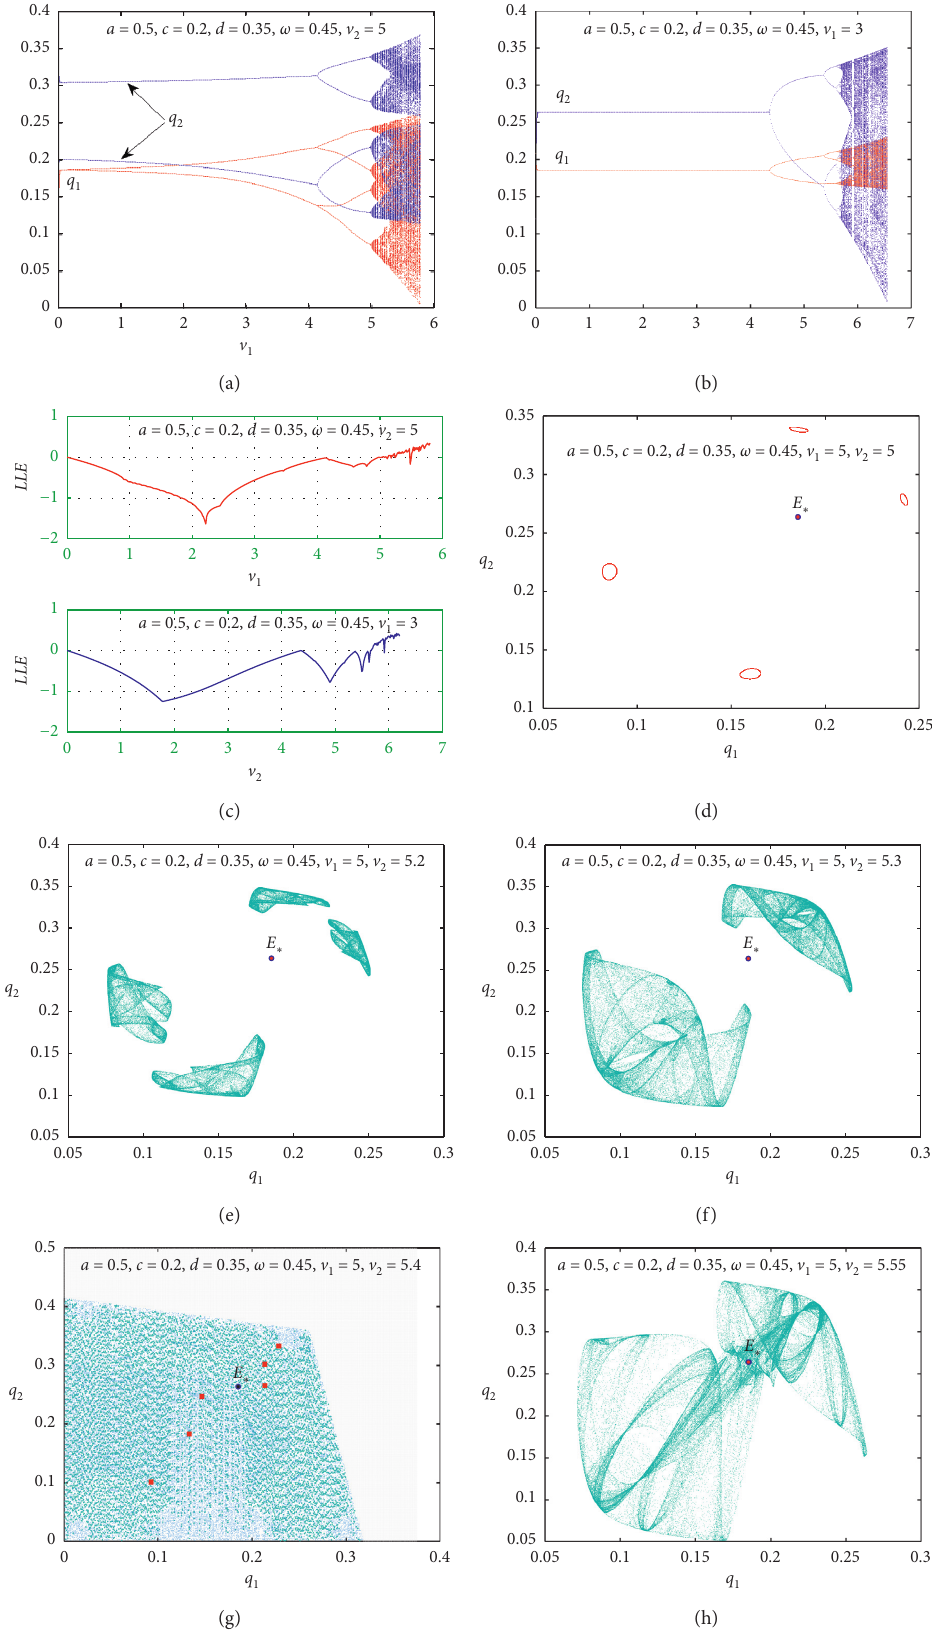
Figure 3: (a),(b) Bifurcation diagram with respect to q ] . Phase plane for (d) four closed invariant sets at ] 2 � 5 and ] � 5 . 3. (g) Basins of attraction of period-6 cycle at ] ] 1 2 � 5 . 55. Other parameters are a � 0 . 5 , c � 0 . 2 ,d � 0 . 35, and ω � 0 . ] 2